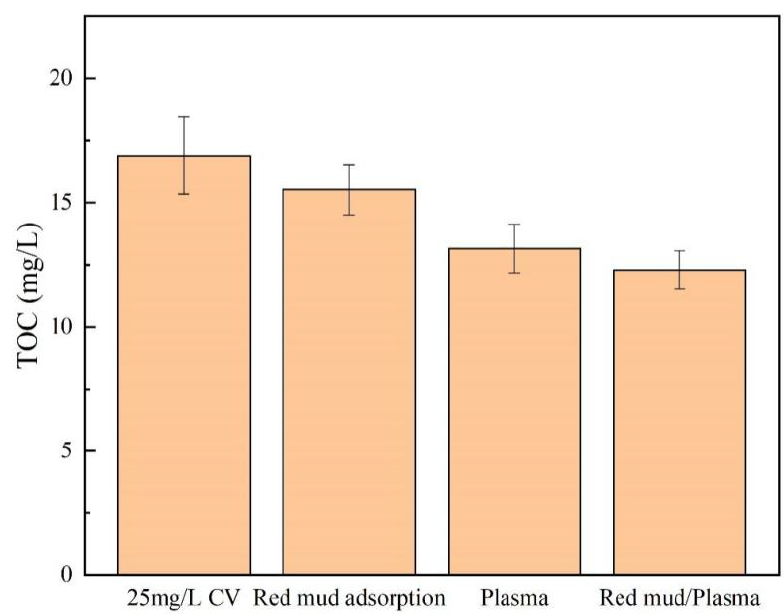
Figure 3. Changes in TOC after 30 min of CV treated by three methods. (Initial CV concentration = 25 mg/L, discharge voltage = 22 kV, frequency = 50 Hz, aeration O 2 = 3.0 L/min, red mud dosage = 2.0 g, conductivity = 26 µ s/cm).